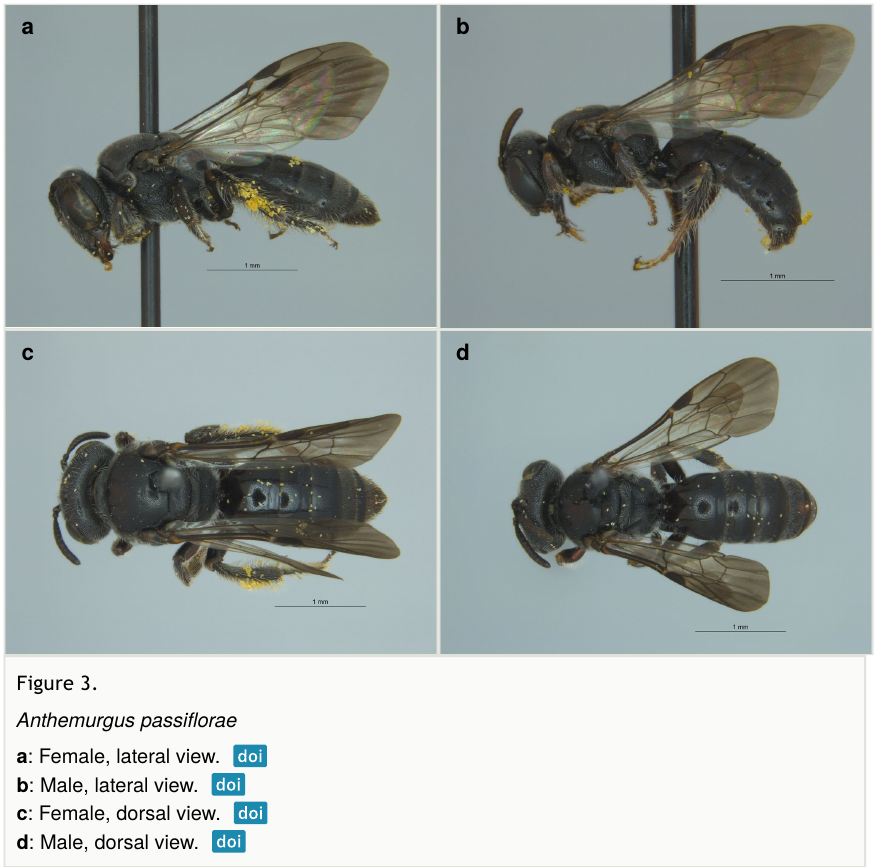
Figure 3. Anthemurgus passi fl